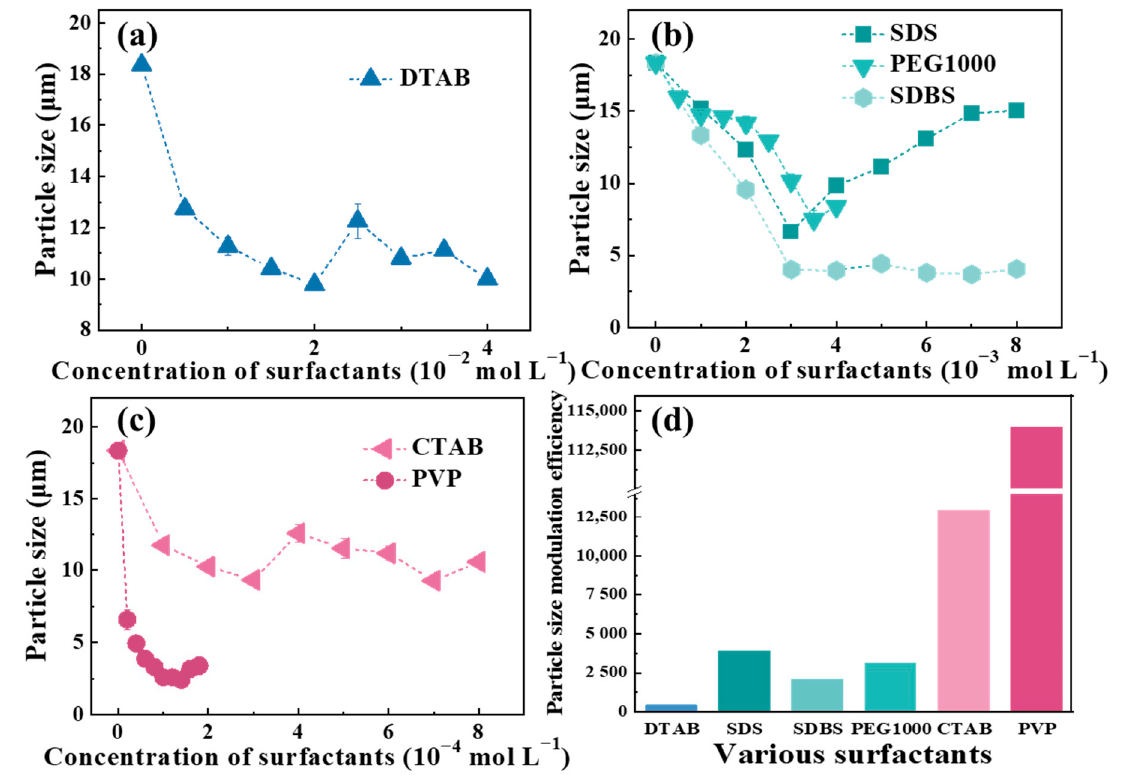
Figure 1. Effect of surfactants on the particle size of Cu-BTC: ( a ) DTAB; ( b ) SDS, SDBS, and PEG-100; ( c ) CTAB and PVP. ( d ) Concentration normalized particle size reduction of Cu-BTC using involved surfactants. Note that particle size modulation efficiency refers to the concentration normalized particle size reduction.